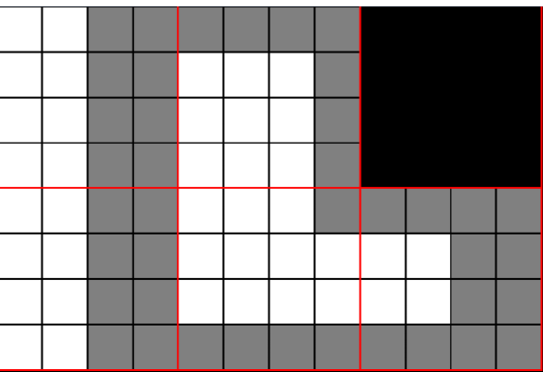
Figure 15. Office block without outdoor connection—the building should be excluded.